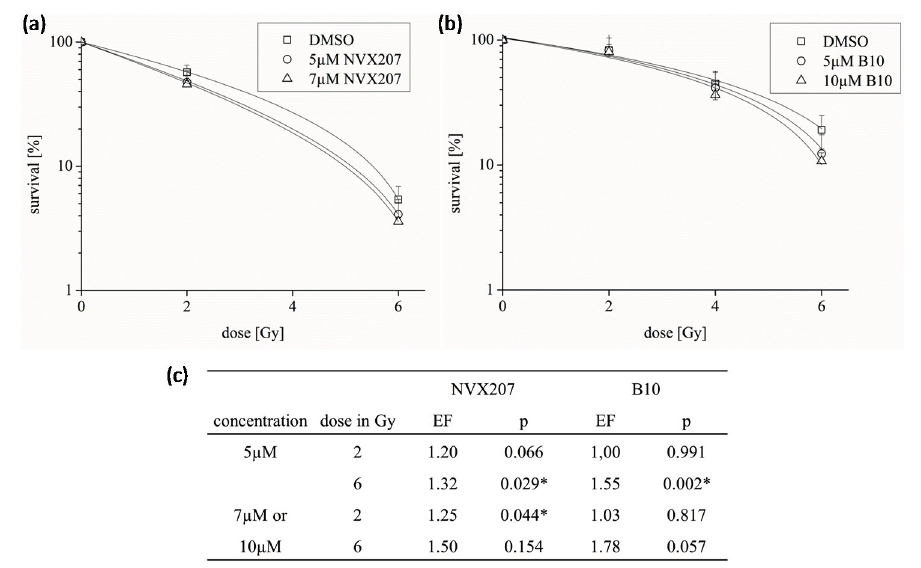
Figure 7. Effects of NVX-207 and B10 on the radiosensitivity of glioma cells. U251MG cells were treated with NVX-207 ( a ) or B10 ( b ) and irradiated with a dose of 2 and 6 Gy under normoxic conditions ( c ). The data represent the mean values (±SD) of three independent experiments (* p < 0.05). EF, enhancement